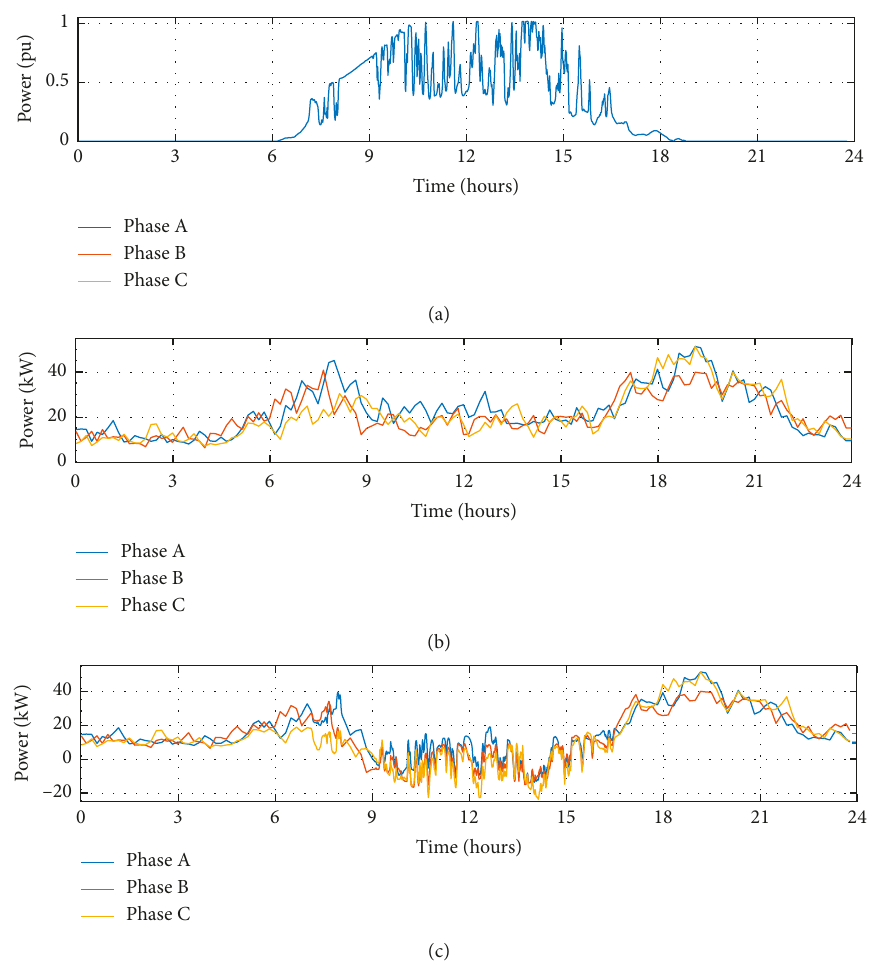
Figure 1: PV power and load demand in one day: (a) normalized PV power profile; (b) load profile without PV power integration; (c) load profile with PV power